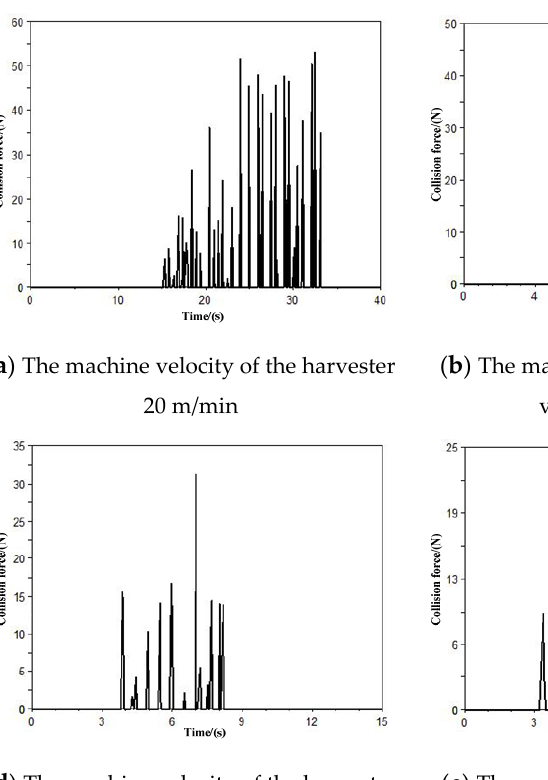
Figure 17. The variation curves of the influence in the rotational velocity of the hydraulic motor. The variation tendency of the curves in Figure 17 was observed and calculated by Equation (14). The F-test value 𝐹 (cid:3051)(cid:3052) of the curves of collision force and the curves of fruit harvesting force was 3.67, which was smaller than the corresponding standard value 𝐹 (cid:2868) : 9.552. Thus, the curves were not significantly different, which indicates that the hydraulic motor’s collision curves of force-rotational velocity and the hydraulic motor’s curves of fruit harvesting force-rotational velocity had a high degree of relevance. In other words, both the collision force and the fruit harvesting force resulting from the interaction be- tween the finger rows of the harvester and the blueberry branch were proportional to the output rotational velocity of the harvesting drive device. When the rotational velocity of the hydraulic motor of the harvesting system was set to 120 r/min and the machine velocity of harvester was set to different values, the collision force curves were obtained according to the harvester and plant harvesting force meas- urement points, which are shown in Figure 18a–f. From these figures, it can be seen that with an increase in the machine velocity of the harvester, the interaction time between the finger rows and the blueberry branch decreased, the number of collisions decreased, the duration of continuous vibration of the blueberry branch decreased, and the collision force formed decreased.